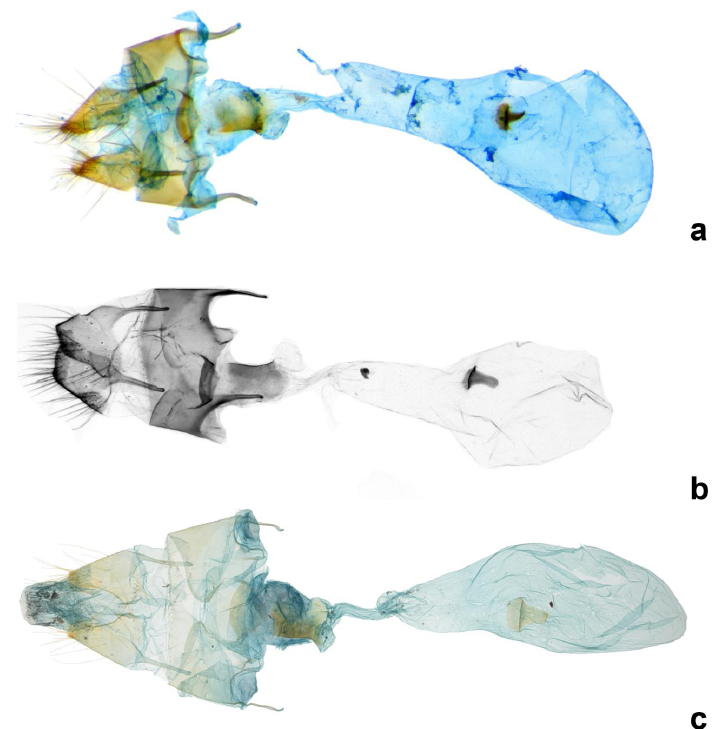
Figure 6. Female genitalia of Nola galliphaga sp. nov. : ( a ) N. galliphaga sp. nov. holotype (NHMUK, gen. slide No. NHMUK 010317817); ( b ) ditto , paratype (HNHM, gen. slide No. RL12334; ( c ) ditto , paratype (KNAE, genitalia slide No. SH-175). 4. Discussion The detailed morphological analyses of the primary types and additional specimens of three East-Asian Nola species have shed light on long-standing taxonomic misinter- pretations of Nola costimacula , N. innocua and N. japonibia . The species, which has long been treated as N. innocua, has proved to be an undescribed species, described here as N. galliphaga , showing a closer kinship to N. costimacula . The true Nola innocua has highly distinctive genitalia features without any known closer relative and has hitherto been only recorded from Taiwan suggesting that the species is endemic to the island. The new species has been reported to feed on galls of two aphid species ( Nipponaphis distyliicola Monzen and Monzenia globuli (Monzen)), and also on their host plant Distylium race-